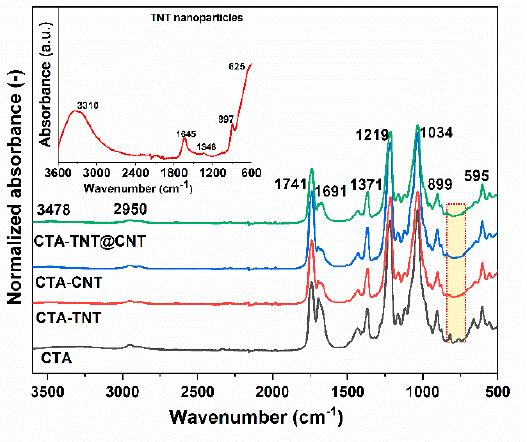
Figure 3. FTIR spectra of the synthesized membrane samples. The inset is the FTIR of the TNT nanoparticles.